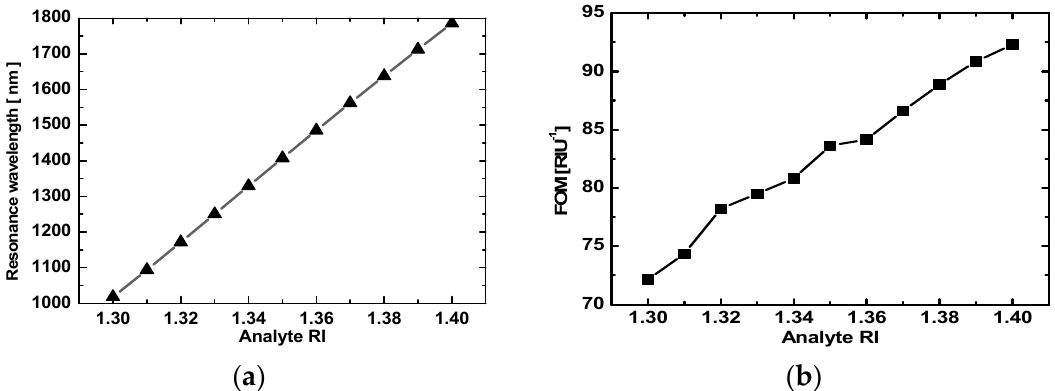
Figure 3. Two RI sensor properties for coupling via an equilateral triangular prism. ( a ) The resonance wavelength as a function of analyte RI with a linear fit produced a slope of 7724.9 nm/RIU; and ( b ) the FOM as a function of analyte RI.